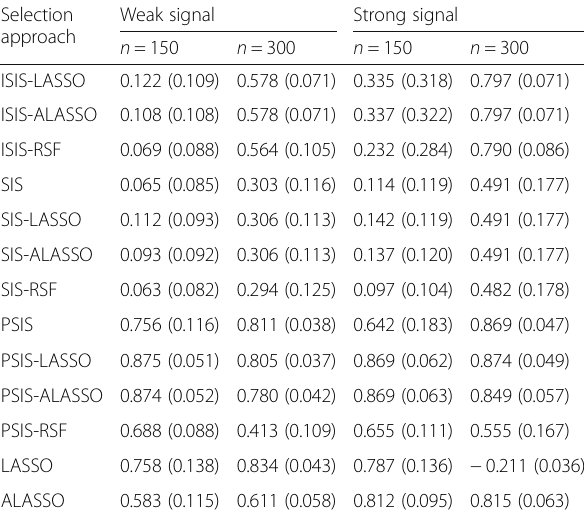
Table 1 Mean (SD) of R 2 BS ð 2 Þ for the training sets over 300 simulations Selection Weak approach